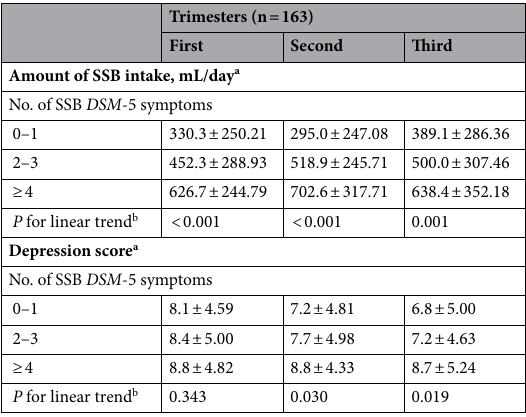
Table 4. Sugar-sweetened beverage (SSB) intake amounts and depression scores among women with different number of DSM-5 symptoms in each trimester of pregnancy. a Data are presented as mean ± standard deviation. b p values for linear trend were obtained using regression models adjusted for age, educational level, body mass index, nulliparous, and comorbidity in pregnancy.